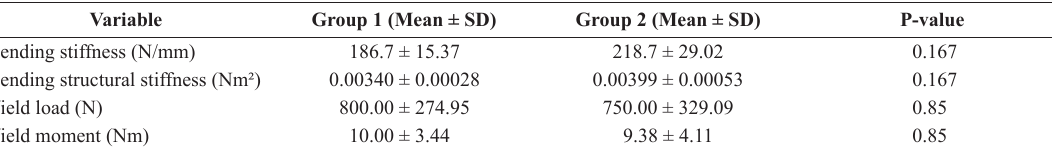
Table 2. Mean values and standard deviation (SD) for each variable evaluated in Groups 1 and 2 under static four-point bending tests.